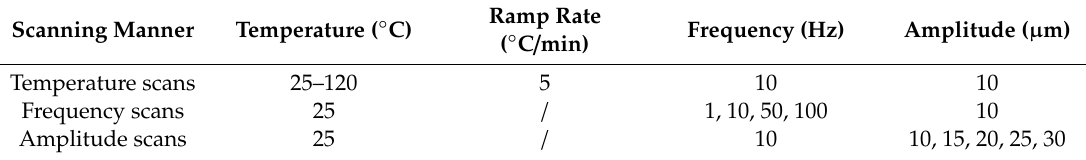
Table 2. The test parameters setting of